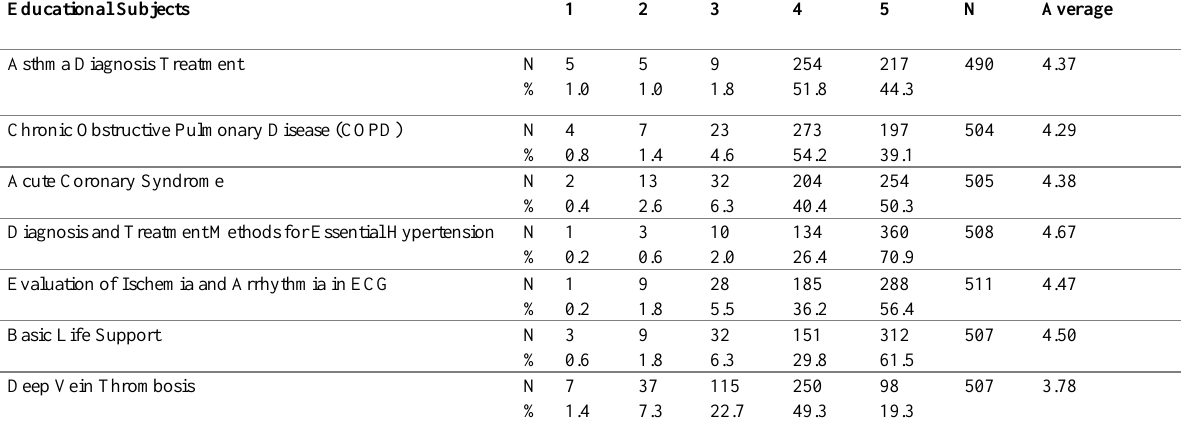
Table 21: Necessity of Professional Development for Family